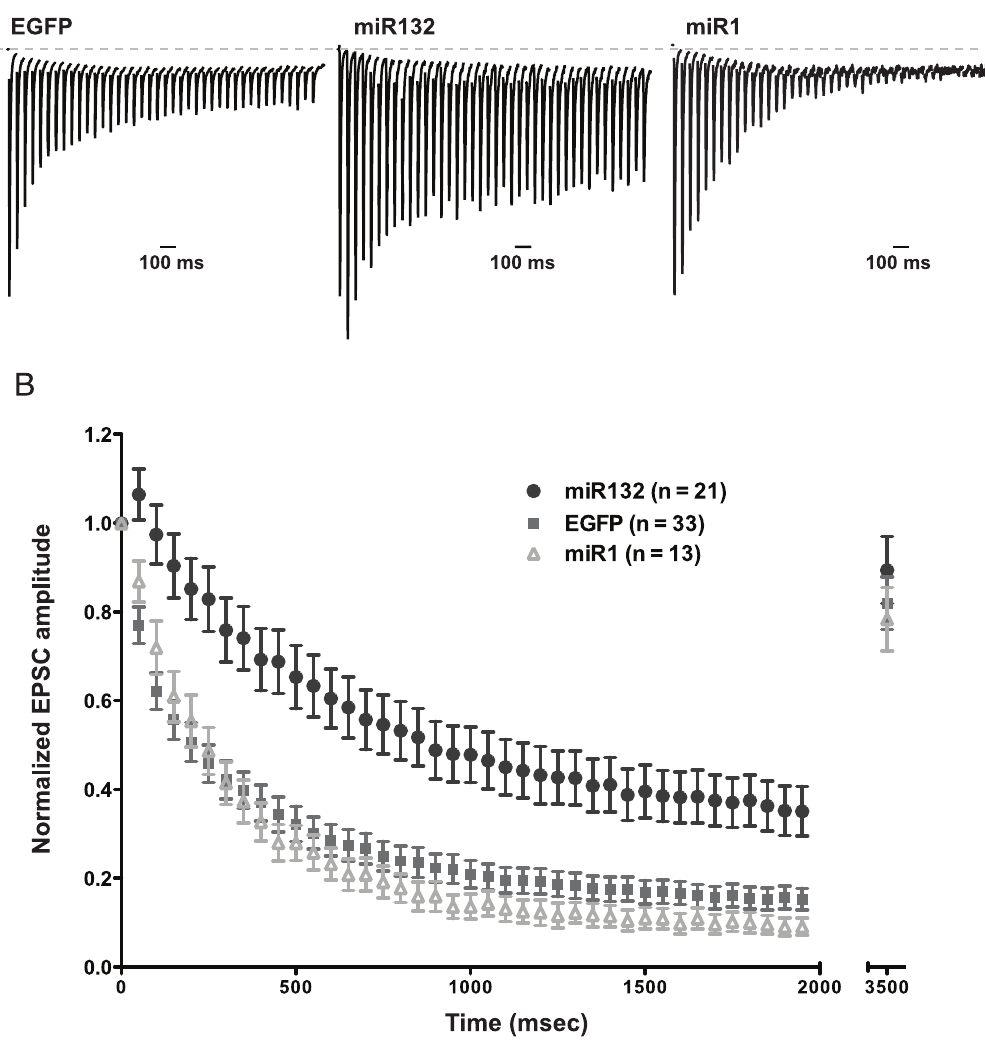
Figure 2. Overexpression of miR132 decreases synaptic depression in response to a train of stimuli, but does not affect the rate of refilling of the RRP. (A) Representative traces showing responses to a train of 40 stimuli delivered at 20 Hz. Data were collected at a rate of one train every 60 s to allow full recovery between trains. Traces have been normalized to the amplitude of the first stimulus in the train to facilitate comparison of synaptic depression. (B) The peak amplitude of each EPSC in the train was normalized to the peak amplitude of the first EPSC and plotted versus time to show the rate of depression during the train. The amplitude of a single EPSC evoked 1.5 s after the end of the train was used to measure recovery from depletion of the pool of readily releasable vesicles. Neurons overexpressing miR132 demonstrate significantly reduced synaptic depression during the train relative to EGFP and miR1-overexpressing controls at all time points ( P , 0.05), but no change in recovery after the train.